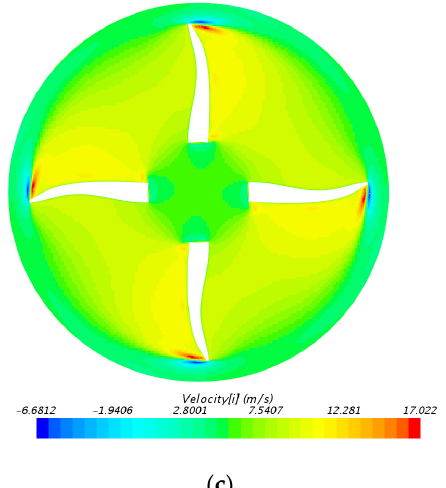
Figure 10. Axial velocity at propeller surface. ( a ) Axial velocity of parent blade; ( b ) Optimization 1 the axial velocity of blade; ( c ) optimization 2 blade axial velocity.